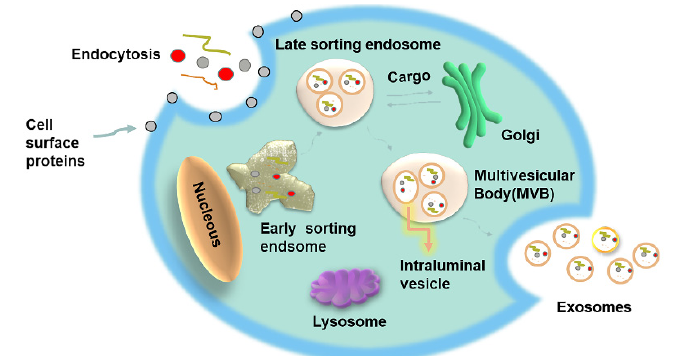
Figure 1. Exosomes biogenesis. Exosomes are formed by inward budding from the endosomal membrane, which leads to the formation of multivesicular bodies (MVBs). MVBs can be fated for lysosomal degradation or fusion with the plasma membrane, which is associated with the release of exosomes.